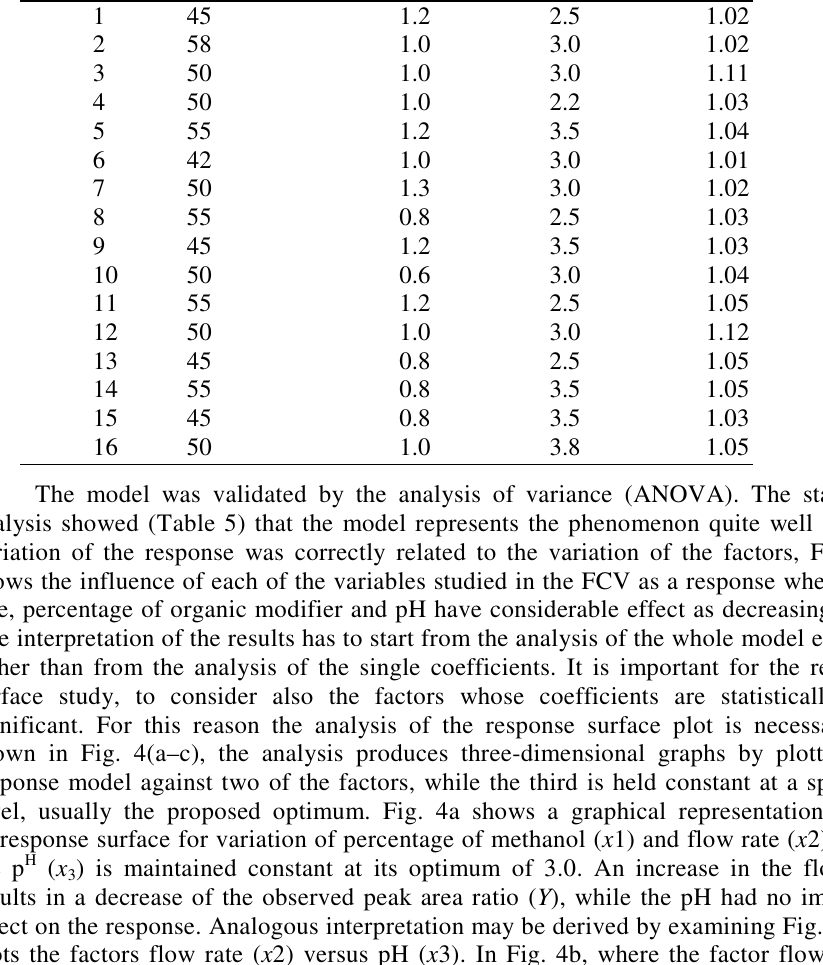
Table 4 . Experimental plan for robustness and obtained response. Exp.